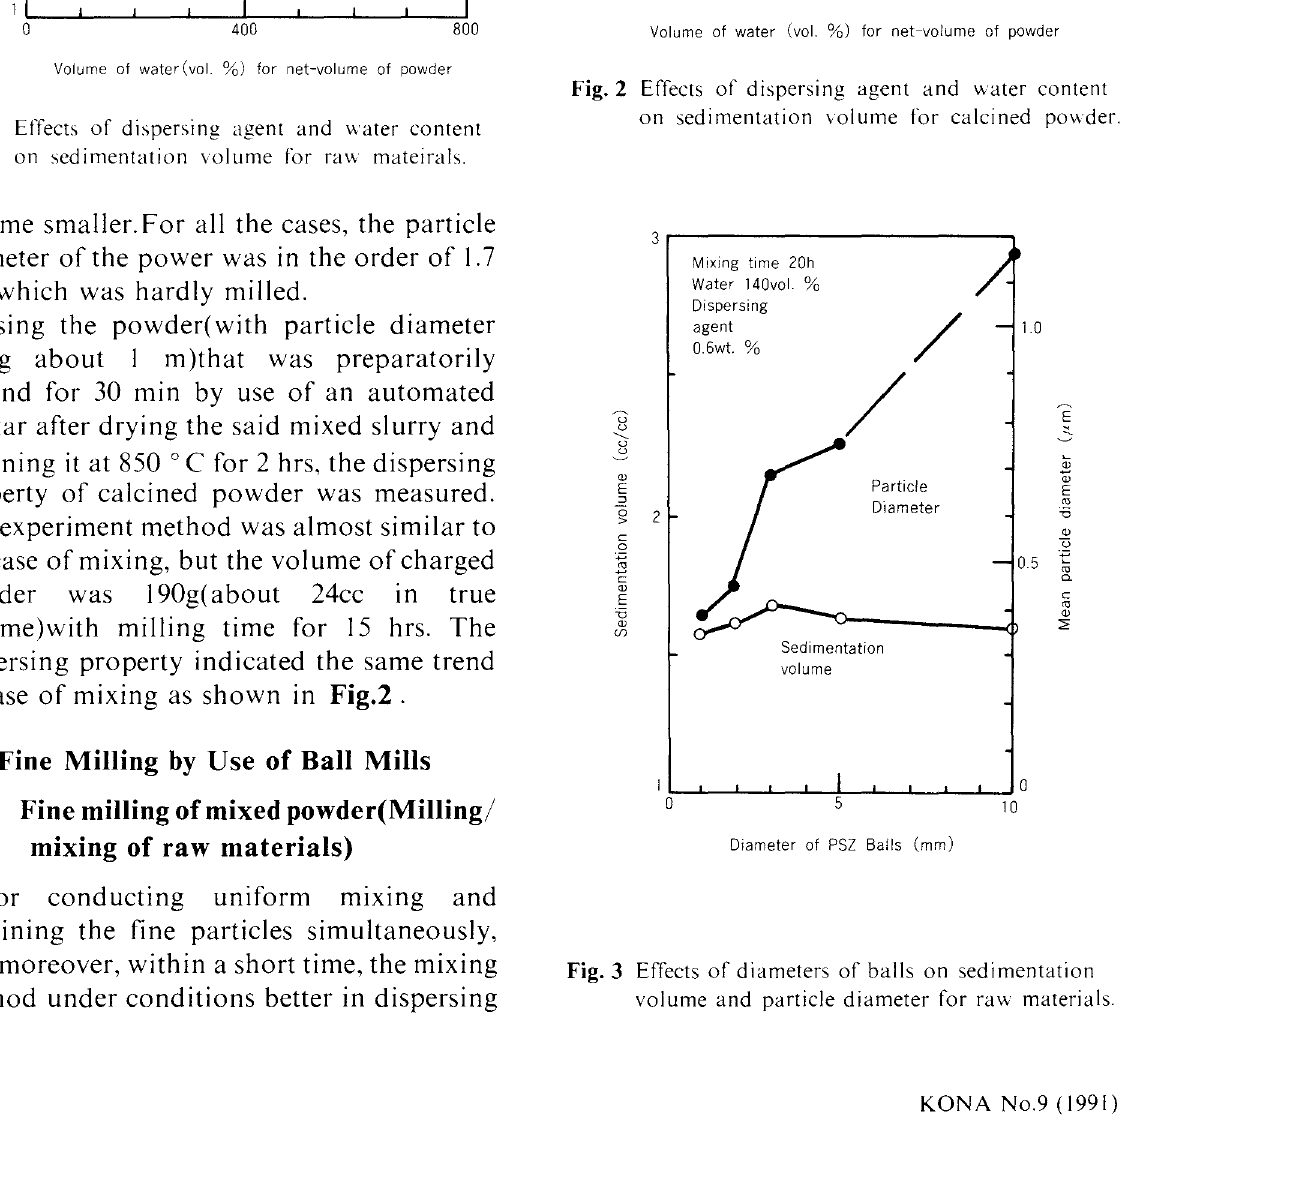
Fig. 2 Effects of dispersing agent and water content on sedimentation volume for calcined powder.